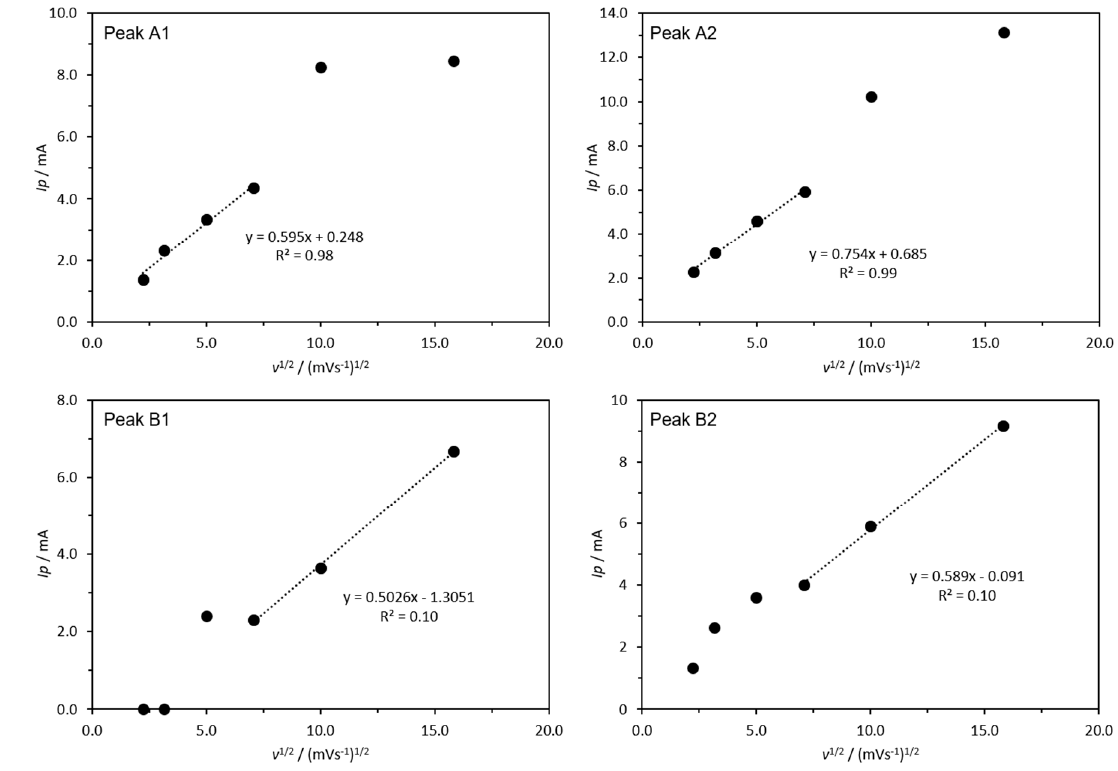
Figure 6. Curves of peak current intensity Ip vs. square root of scan rate ( v 1/2 ) for the distinguished oxidation peaks in the SMFC with the carbon Toray anode (peak A1 and peak A2) and with the stainless steel anode (peak B1 and peak B2).